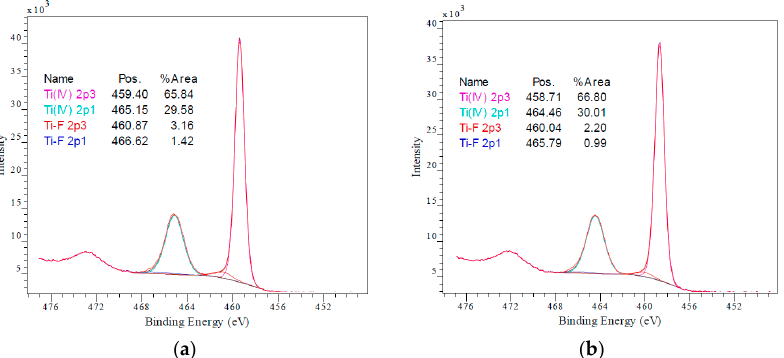
Figure 3. High resolution Ti 2p spectra of TiO 2 ( a ) and treated-TiO 2 ( b ) Original measurements given in red with brown denoting the sum of the fitted curves.